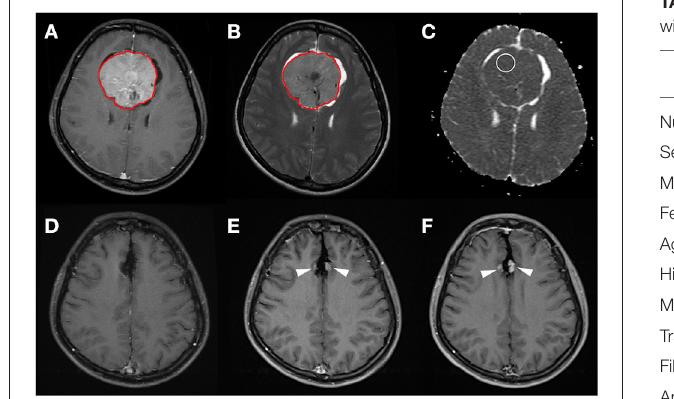
FIGURE 2 | A 31-year-old woman with pathologically proven parafalcine meningioma (WHO grade I). (A) Axial CE T1WI showing an enhancing parafalcine tumor (red outline) at the frontal region. The tumor (red outline) is segmented on axial CE T1WI (A) and then mapped onto axial T2WI (B) . The SVM score based on the four selected radiomic features is 0.831. (C) The measured ADC value (circular ROI) is 0.805 × 10 − 3 mm 2 /s ( b = 1,000 s/mm 2 ). (D) Gross total tumor resection is performed. (E,F) Progressive recurrence of tumor (arrowheads) was observed in 36 months (E) and 60 months (F) after surgery.